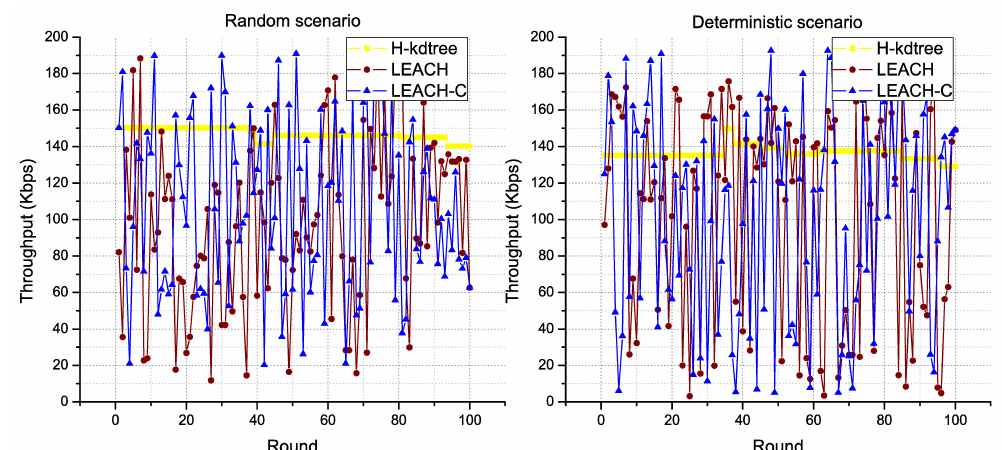
Figure 16. Throughput